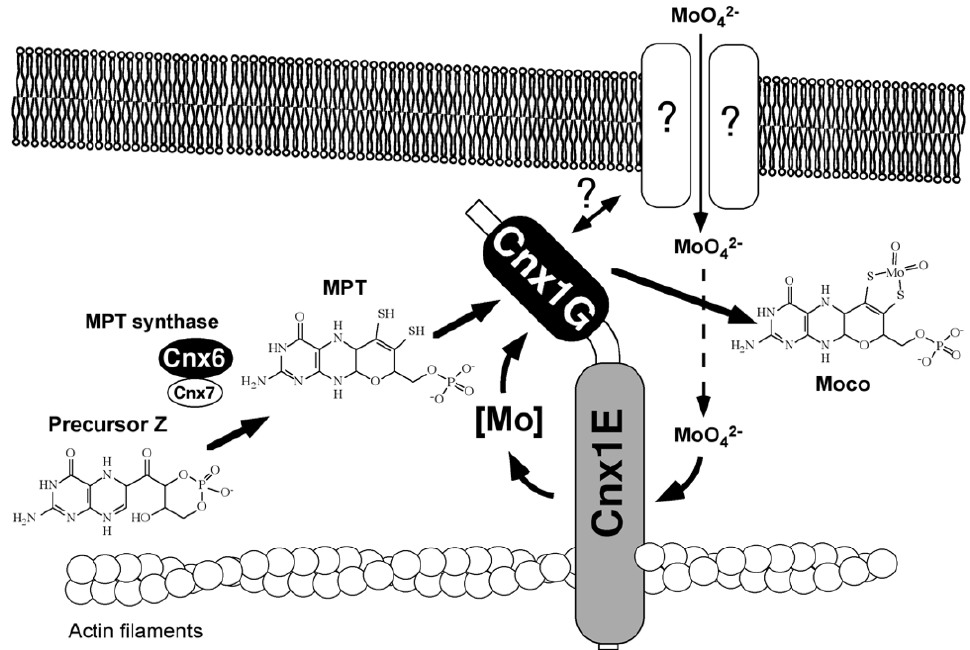
Figure 4. Model for the Moco biosynthesis pathway in plants, published by Schwarz et al. in the year 2000 [129]. Cnx1 is shown to be bound to an actin filament. An unidentified molybdate transport system was proposed that interacts with Cnx1 to facilitate molybdate channeling to the E domain, given that a mutation in this protein results in a molybdate-repairable phenotype. The conversion of precursorZ cPMP) to MPT by the MPT synthase (Cnx6 and Cnx7) is shown. MPT is highly sensitive to oxidation; therefore, it was suggested that the rapid conversion of precursorZ to Moco should occur in a multienzyme complex anchored by Cnx1 on the cytoskeleton. Modified after Schwarz et al. [129].